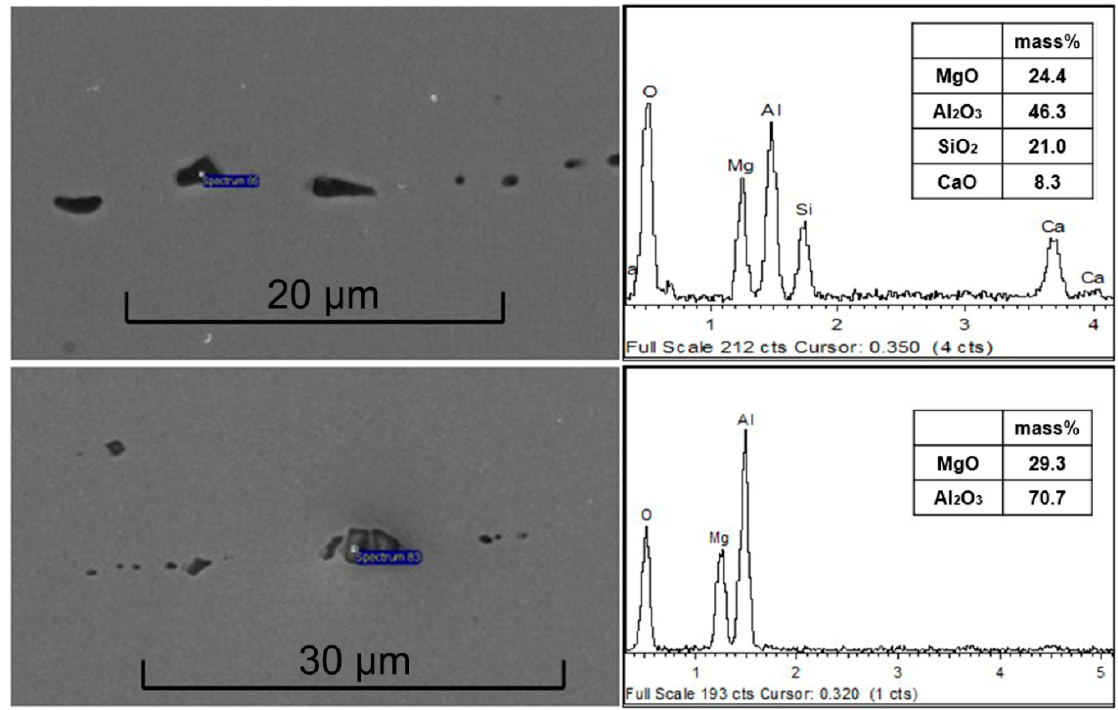
Figure 8. SEM images and EDS results of inclusions in hot rolled plates when using low-Al FeSi alloy during AOD reduction.